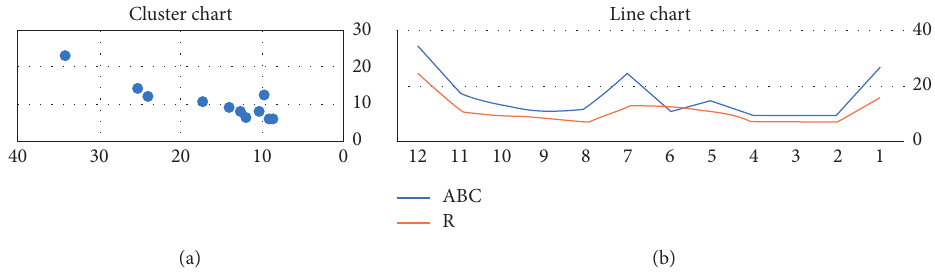
Figure 4: Cluster and line chart of R and ABC.